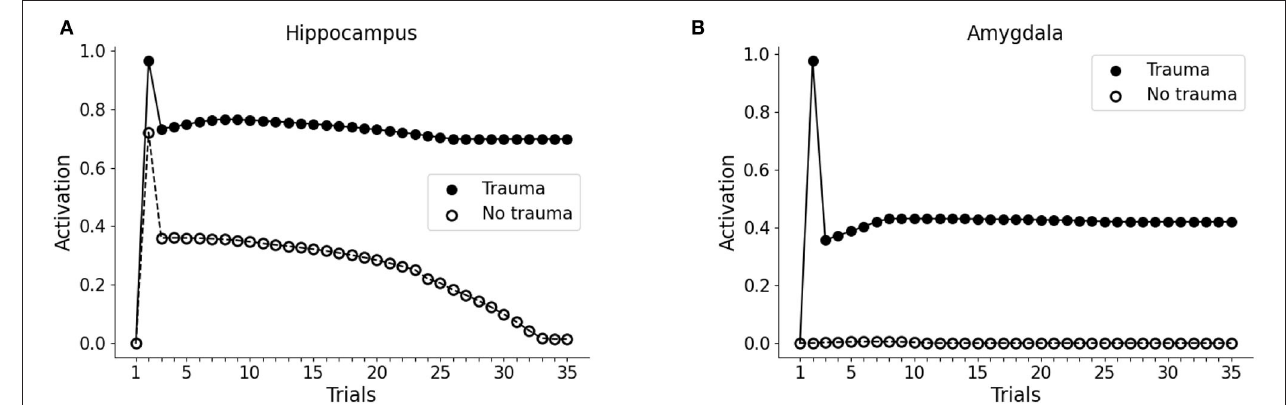
FIGURE 2 | Effect of trauma establishment in hippocampus and amygdala, compared to the control. In the first trial, the baseline activity of the hippocampus (A) and amygdala (B) were measured during the stimulation of the V1 or the V2 sensory units. In trial 2, pattern 1 (A1-S1-V1) was coactivated with the trauma unit; as a control, pattern 2 (A2-S2-V2) was activated with the trauma unit turned off. During trial 3 and succeeding trials, V1 and V2 were repeatedly activated to investigate the dynamics of the hippocampus and amygdala response. After memory establishment in trial 2, V2 stimulation induces the activation of the hippocampus ( A , white dots, trials 3–30), but not of the amygdala ( B , white dots, trials 3-35). On the other hand, the trauma-associated stimulus V1 induces both hippocampus ( A , black dots, trials 3–35) and amygdala ( B , black dots, trials 3–35). Over time, the non-traumatic memory trace is lost ( A , white dots, trial 35), while traumatic associated stimulus V1 is persistently capable to activate the hippocampus ( A , black dots, trial 35) and amygdala ( B , black dots, trial 35).